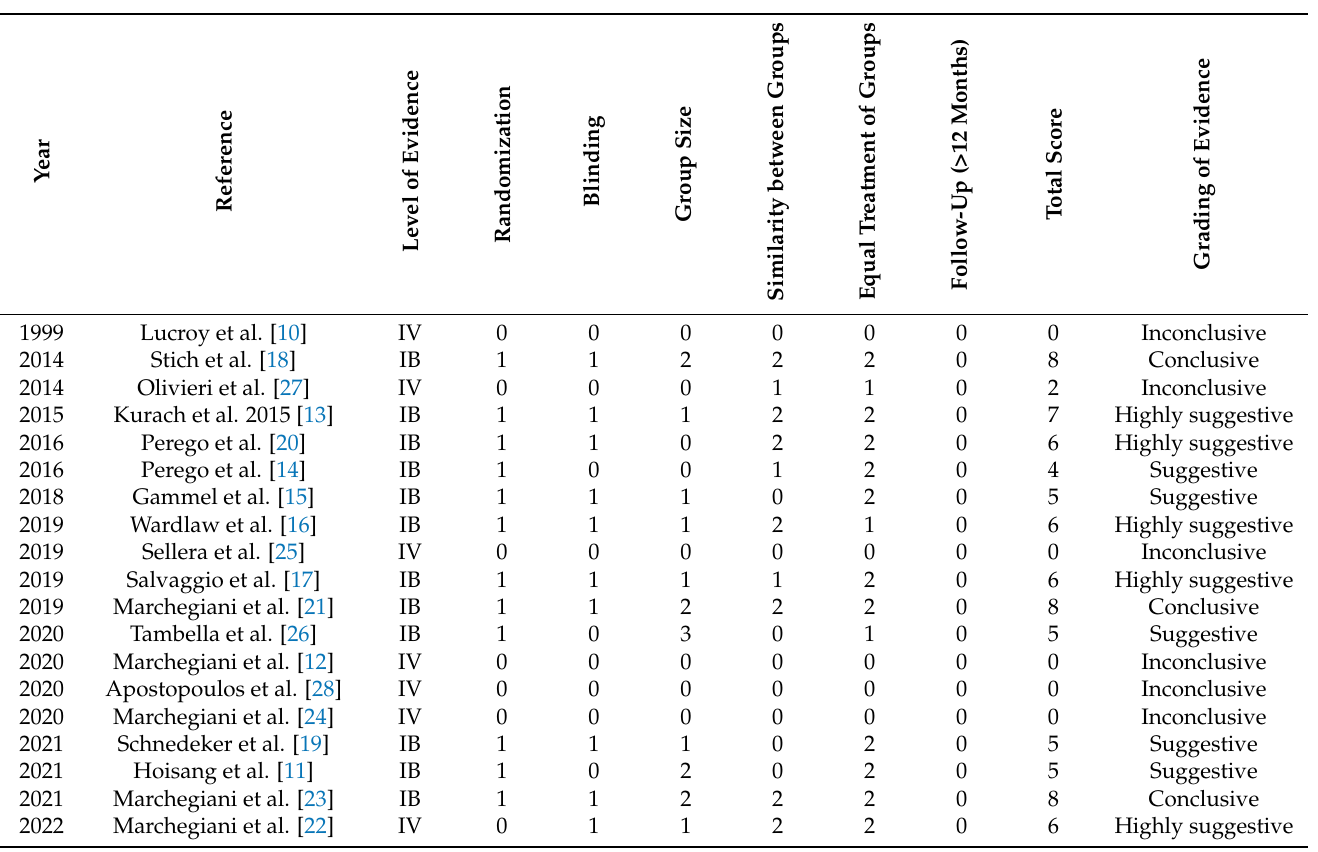
Table 2. Assessment of scientific evidence of the studies. The studies are categorized as conclusive evidence (total score 8–10), highly suggestive evidence (total score 6–7), suggestive evidence (total score 4–5), or inconclusive evidence (total score ≤ 3).